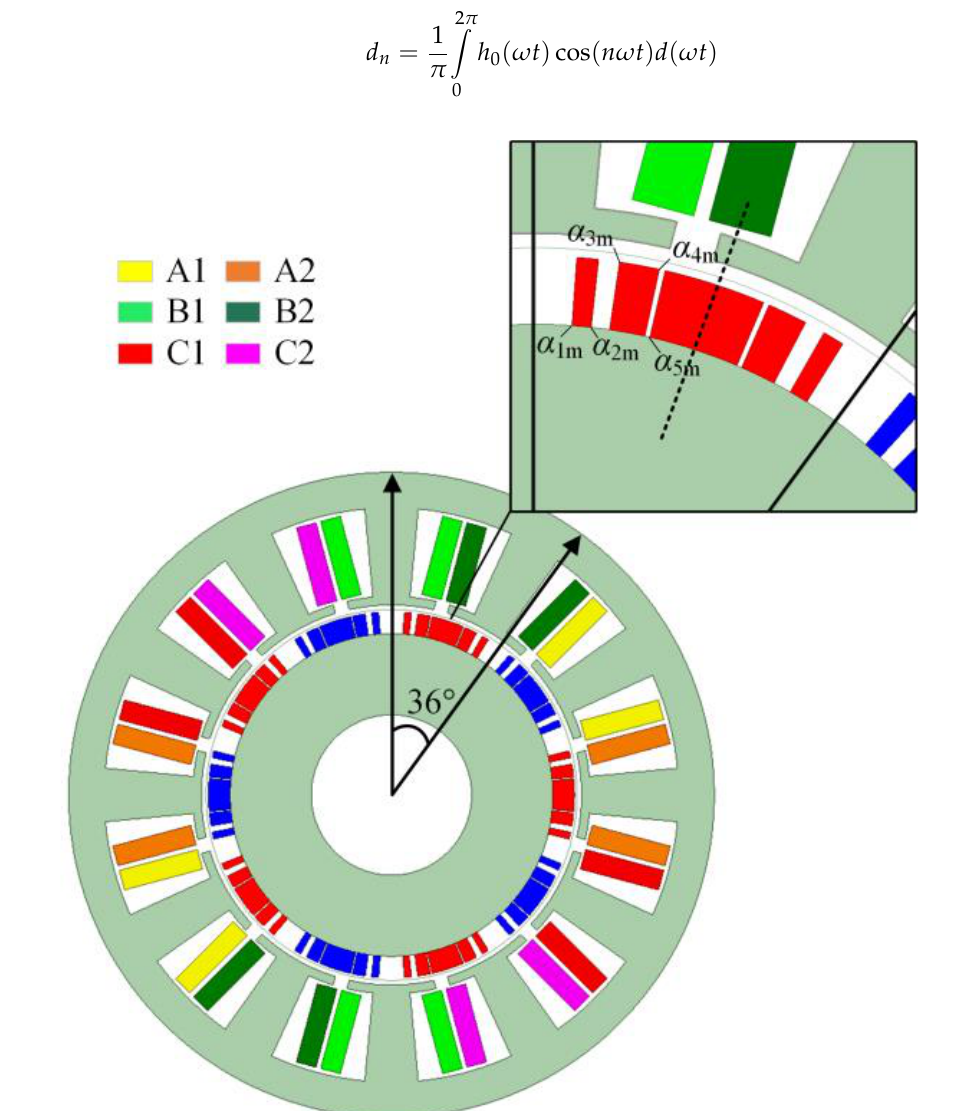
Figure 3. The cross-section picture of the machine in the position of different α i m